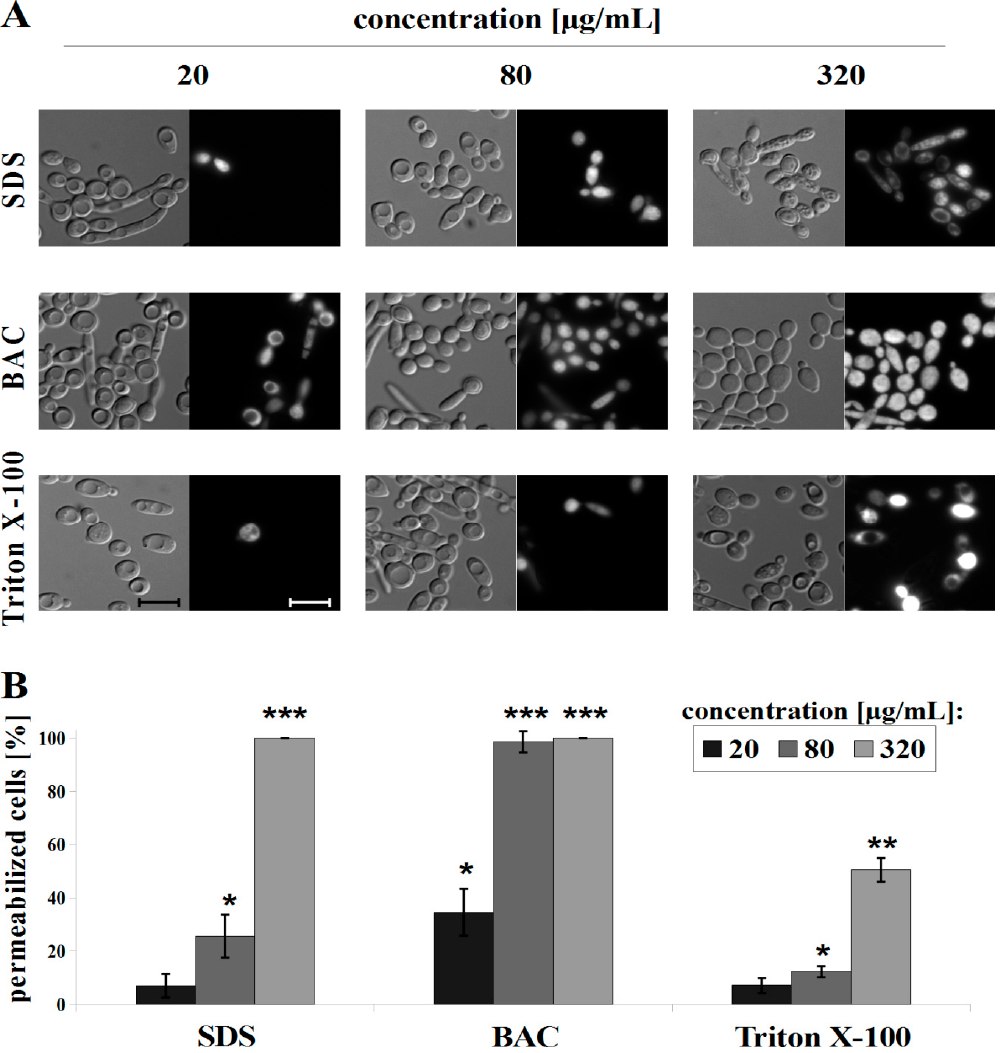
Figure 5. C. albicans CAF2-1 strain staining with propidium iodide (PI) after treatment with detergents: SDS, BAC and Triton X-100, presented as: ( A ) microscopic observations, scale bar = 10 µm and ( B ) histograms of the counted % of permeabilized cells, means ± SD (n = 3), statistical analysis at each concentration was performed relative to control experiment without detergent (* p < 0.05; ** p < 0.01; *** p < 0.001).